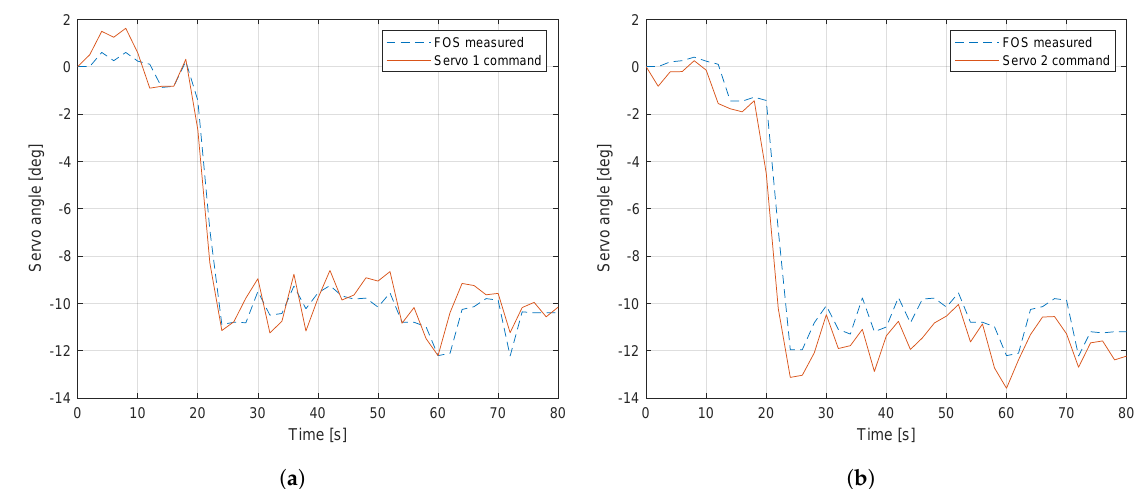
Figure 13. Estimated position with respect to module #6 deflections for the F y = 20 and M x = 0 case. The positions of actuators 1 and 2 are separated and shown in ( a , b ), respectively.